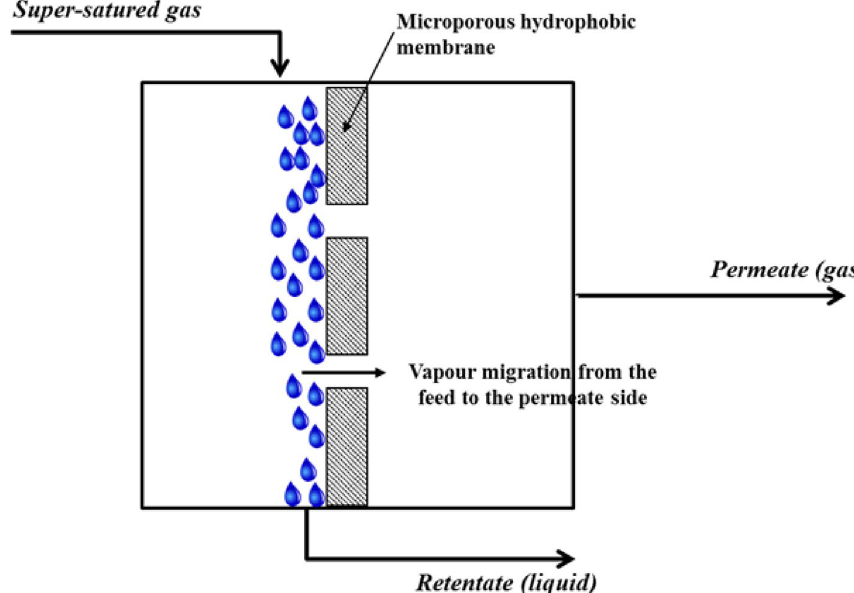
Fig. 1 Membrane condenser principle (Macedonio et al.